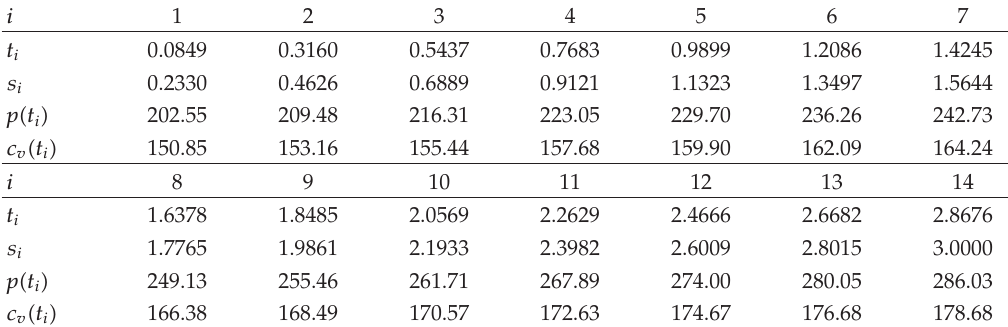
Table 2: The optimal replenishment schedule for Example 5.1.